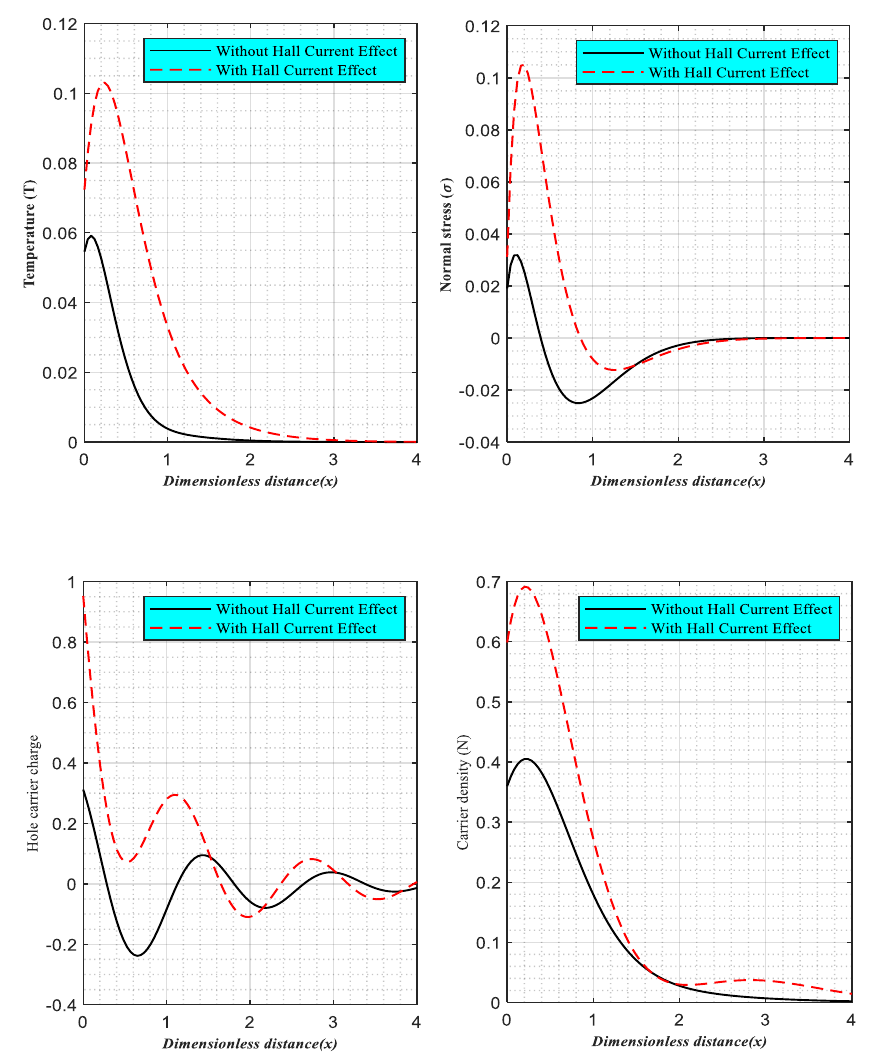
Figure 4. Hall current’s influence on the distribution of main fields with distance, as predicted by the DPL model, when exposed to laser